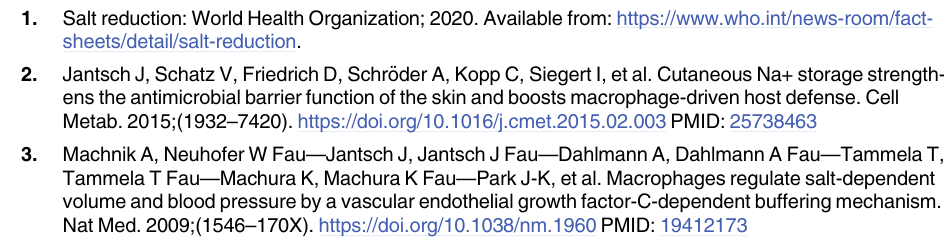
S1 Fig. Effect of 8% high salt (NaCl) diet on body weight. Mice were kept on NSD or HSD for 14 days. The body weight was measured in every 7 days for two weeks. (n = 6 in each group). (TIF) S1 Raw images. Images of entire Western blot membranes belong to Fig 3F. Internal con- trol (IC). (PDF)